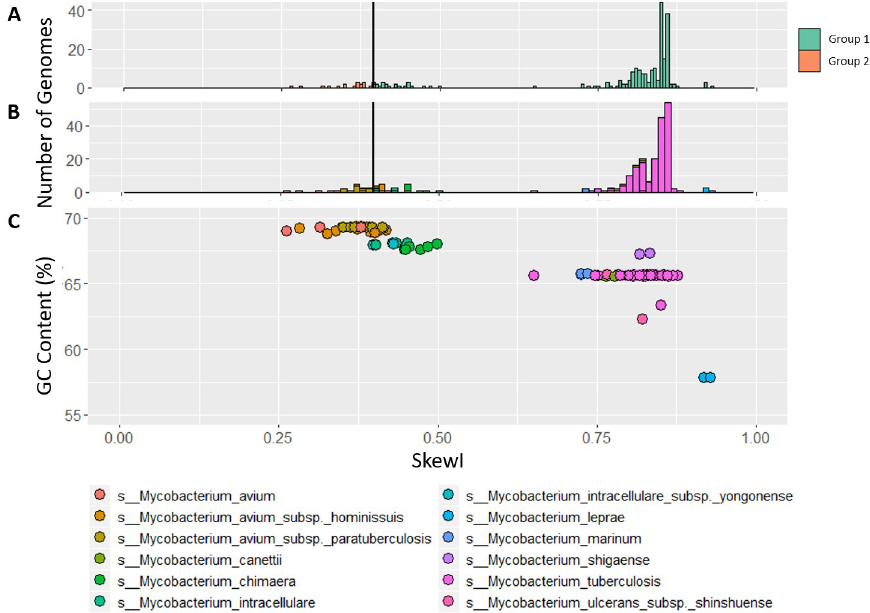
Fig 5. Mycobacterium skew index values. A) SkewI for 236 Mycobacterium genomes from 12 Mycobacterium species, all of which have multiple strains available in RefSeq. The threshold (vertical line) is at 0.413.) SkewI colored by species. C) Plot comparing GC Content (%) to SkewI, where each dot represents a different genome colored by